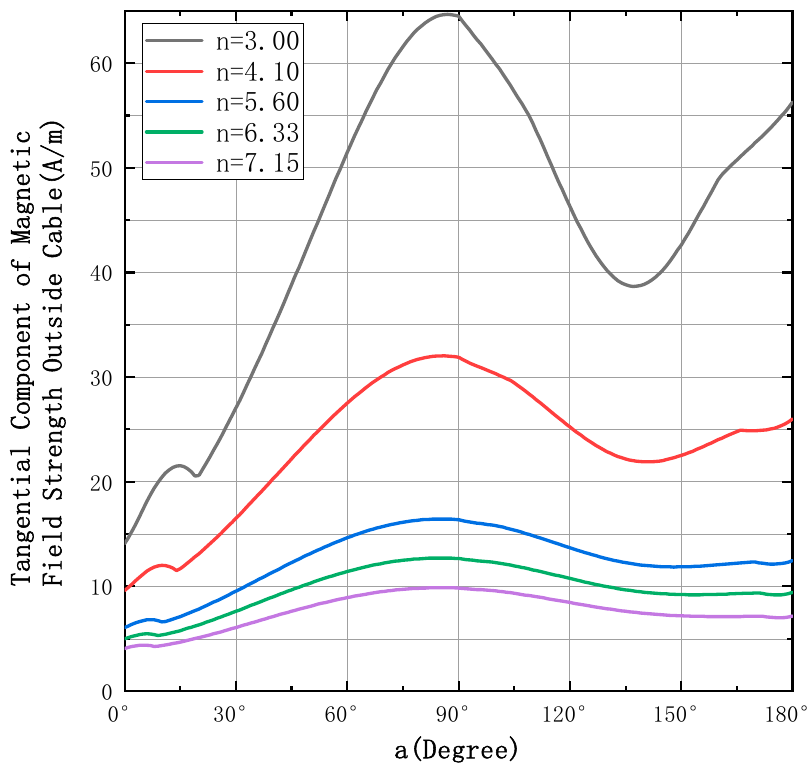
Figure 3. Plot of magnetic field strength amplitude versus “ a ” in the direction of the sensitive axis.